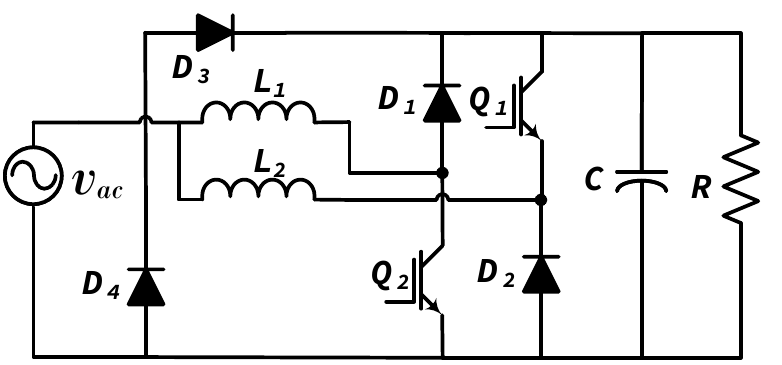
Figure 17. Bridgeless boost converter pseudo totem-pole topology.